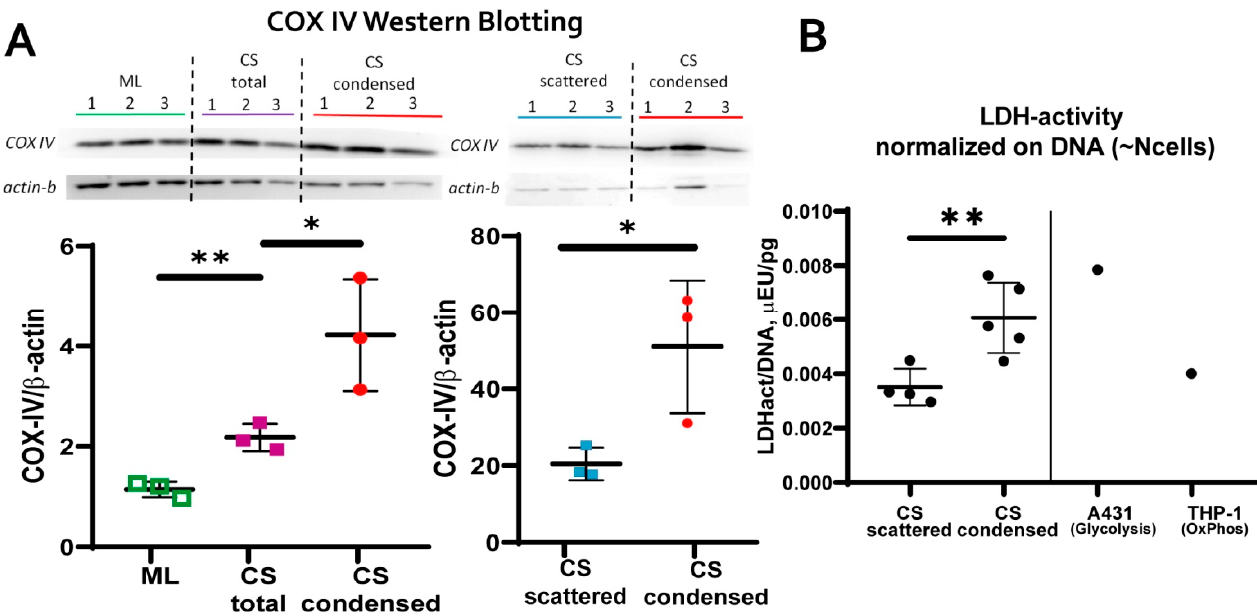
Figure 6. Cells from condensed areas of the cell sheet (CS) are characterized by an increased content of the cytochrome-C oxidase IV component (COX-IV) and higher lactate dehydrogenase (LDH) activity. ( A ) Western blotting of the mitochondrial ETC COX-IV subunit in lysates of ML, total CS and microdissected condensed or scattered areas. Graphs present a densitometry analysis of the COX-IV content normalized to β -actin (densitometry analysis). ( B ) LDH activity (LDHact) in the lysates of microdissected condensed areas and scattered areas. DNA amounts in the respective cell lysates were used for the normalization of LDH activity to the cell number. Control data was obtained from lysates of the A431 cell line that increased the proportion of anaerobic glycolysis and the THP-1 cell line with the major input of oxidative phosphorylation but not glycolysis. The band numbers indicate individual biological replicate samples. In the figure graphs and histograms, significant differences were marked by * ( p < 0.05) and ** ( p < 0.005).